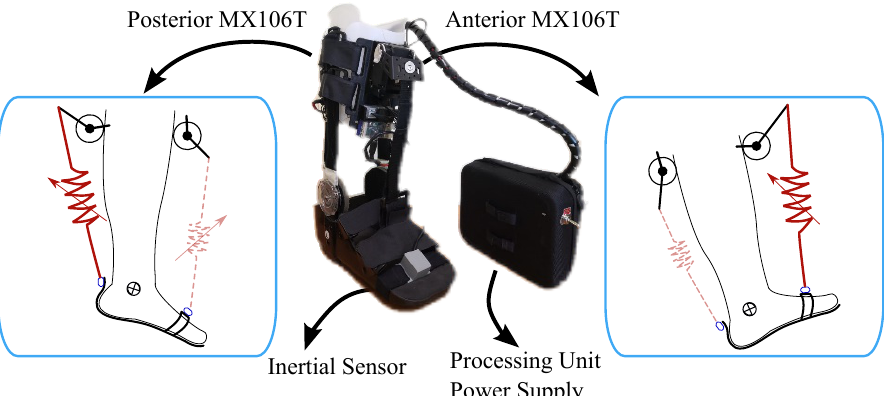
Figure 1. The actuation system of the T-FLEX exoskeleton implemented on a passive orthotic device. The left and right parts show the movements assisted by the device and the involved elements and